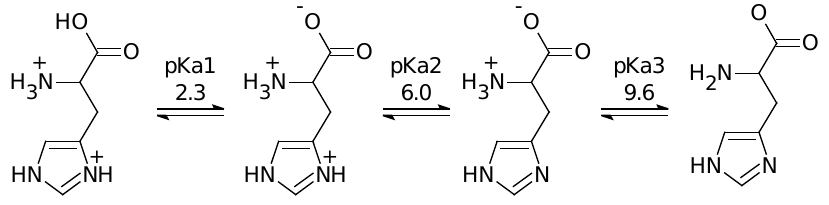
Figure 3. Histidine protonation steps.